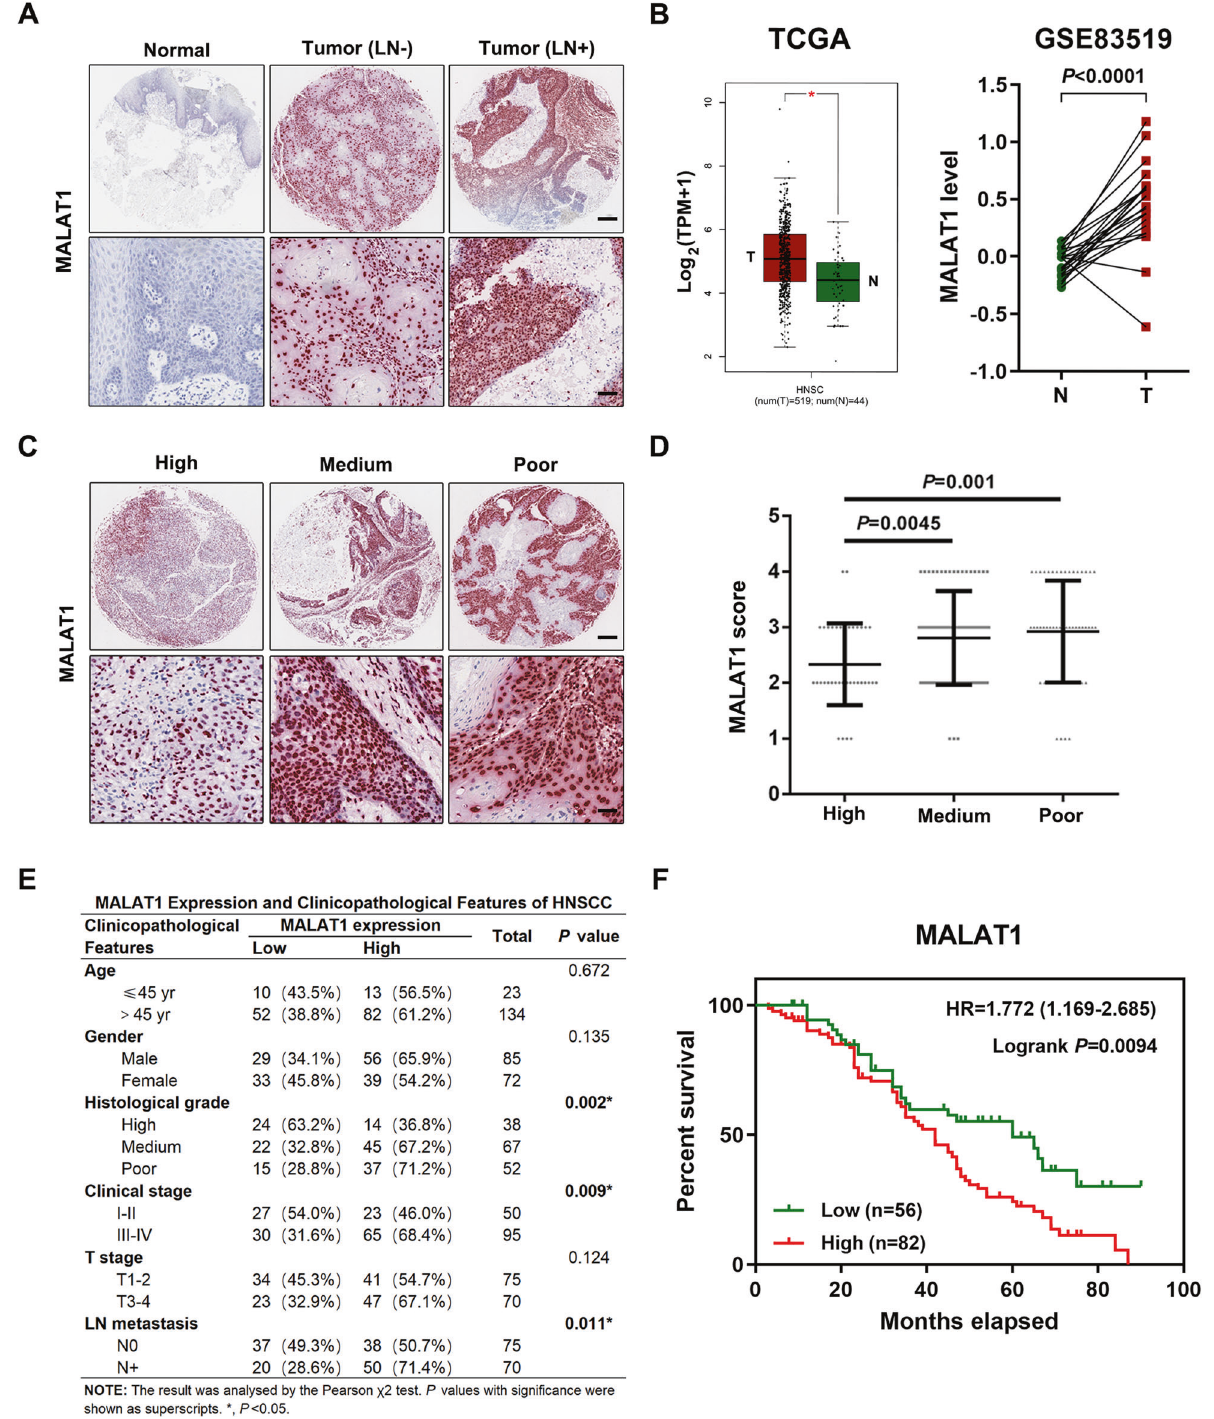
Fig. 1 MALAT1 is a potential biomarker for HNSCC progression and prognosis. A Representative ISH images of MALAT1 in HNSCC specimens (with/without lymph node metastasis) and adjacent normal tissues. Scale bar, 250 μ m (upper) and 25 μ m (lower). LN − , without lymph node metastasis. LN + , with lymph node metastasis. B The bioinformatic analysis of TCGA and GEO (GSE83519) databases showed that compared with normal tissues, MALAT1 was upregulated in HNSCC tissues. Data, mean ± SD, * P < 0.05. T tumor tissues. N normal tissues. TPM transcripts per million. C , D The results of ISH staining showed that the level of MALAT1 correlated negatively with the differentiation degree of HNSCC. Scale bar, 250 μ m (upper) and 25 μ m (lower). Data, mean ± SD. High, high differentiated. Medium, medium differentiated. Poor, poor differentiated. E The correlation between MALAT1 expression and clinicopathological features of HNSCC. 157 cases of HNSCC specimens were analyzed. The results were analyzed by the Pearson χ 2 test. * P < 0.05. F Kaplan – Meier survival curve suggested that enhanced MALAT1 indicated poor prognosis of HNSCC patients in our cohort. HR hazard